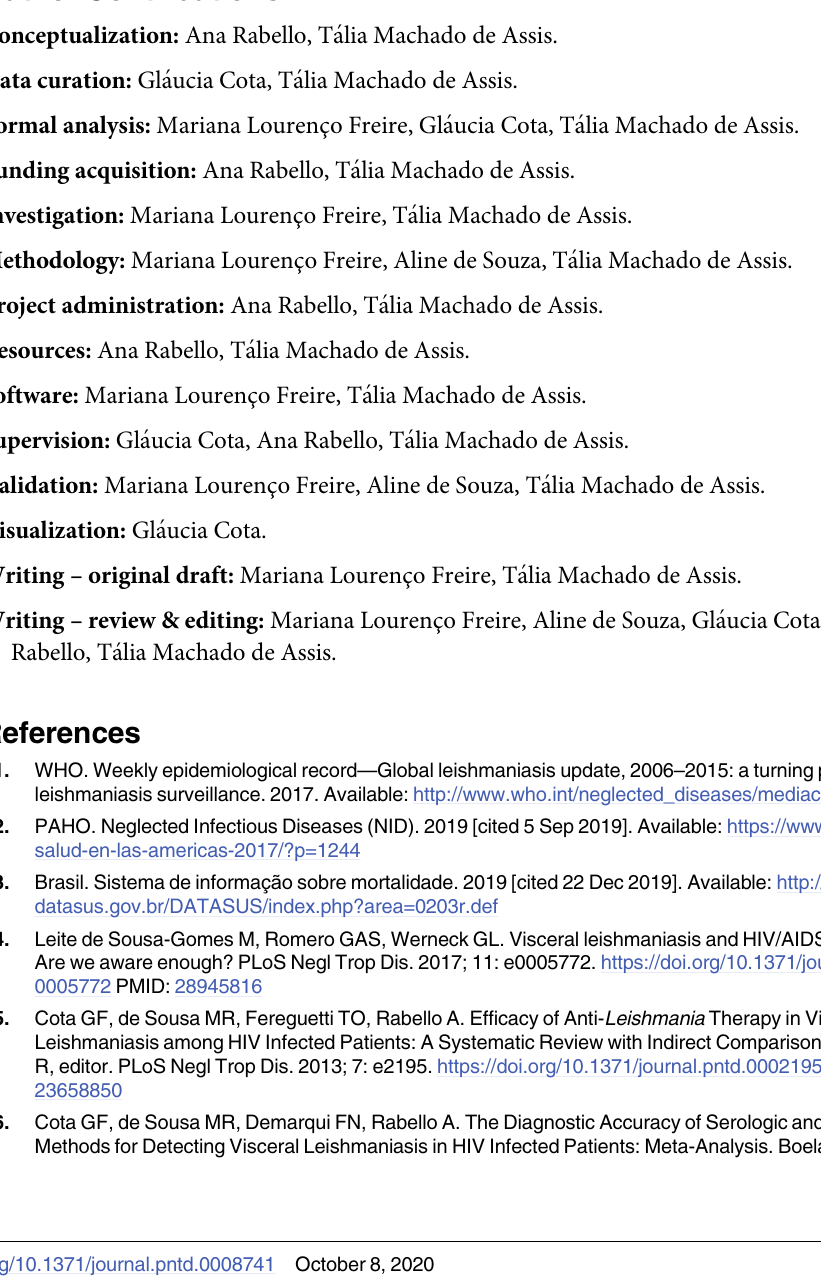
S2 Table. Sensitivity analyses for diagnostic tests for visceral leishmaniasis for HIV-unin- fected patients. S3 Table. Sensitivity analyses for diagnostic tests for visceral leishmaniasis for HIV- infected